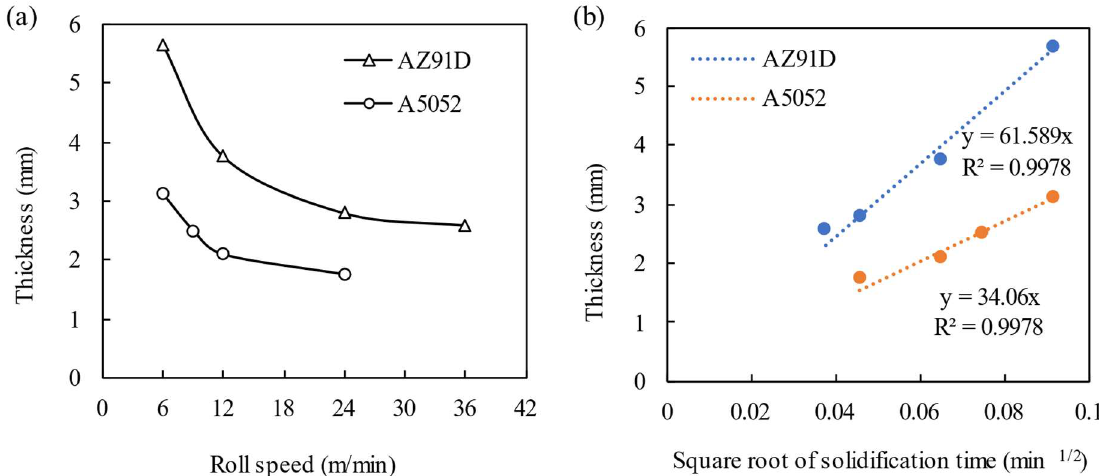
Figure 3. ( a ) Relationship between the roll speed and solidification layer thickness; ( b ) relationship between the square root of the solidification time and the thickness of the solidification layer.